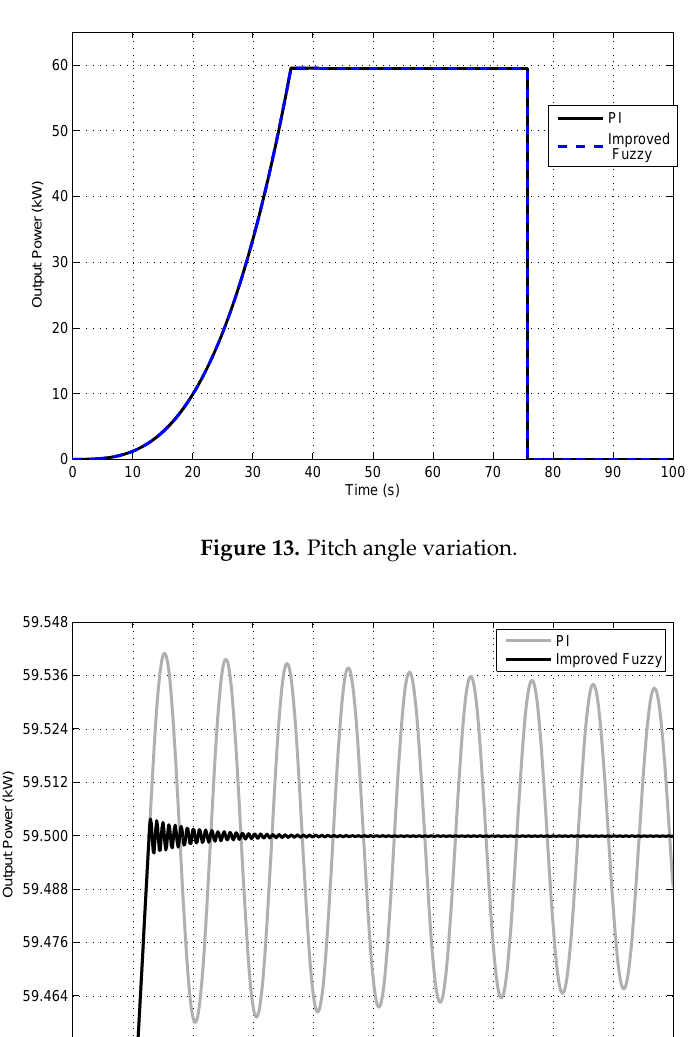
shown in Figure